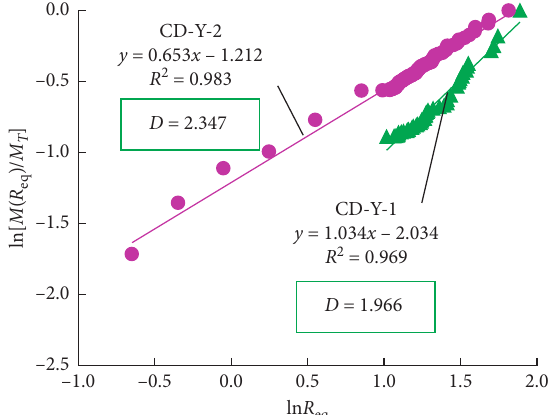
Figure 6: Calculation of fractal dimensions under different min- imum static stress σ y .